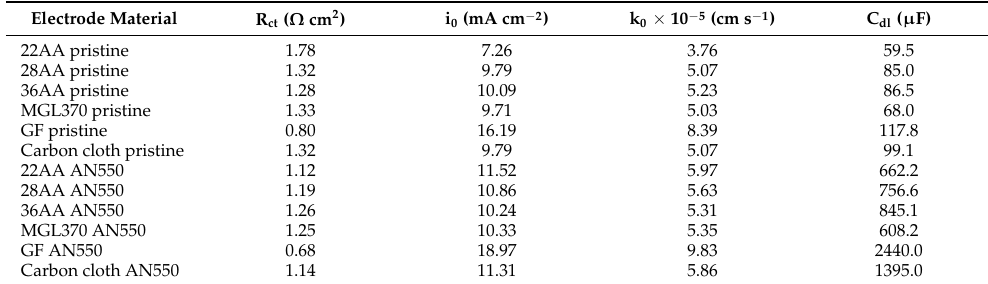
Figure 5. ( a ) LSV curves for pristine samples, ( b ) LSV curves for annealed samples at scan rate of 1 mV/s. 3 M HBr/1 M Br 2 electrolyte, working electrode area 0.1 cm 2 . Temperature 298 K. Table 2. Kinetic parameters of the bromine reduction reaction and capacitances for different carbon materials (pristine and